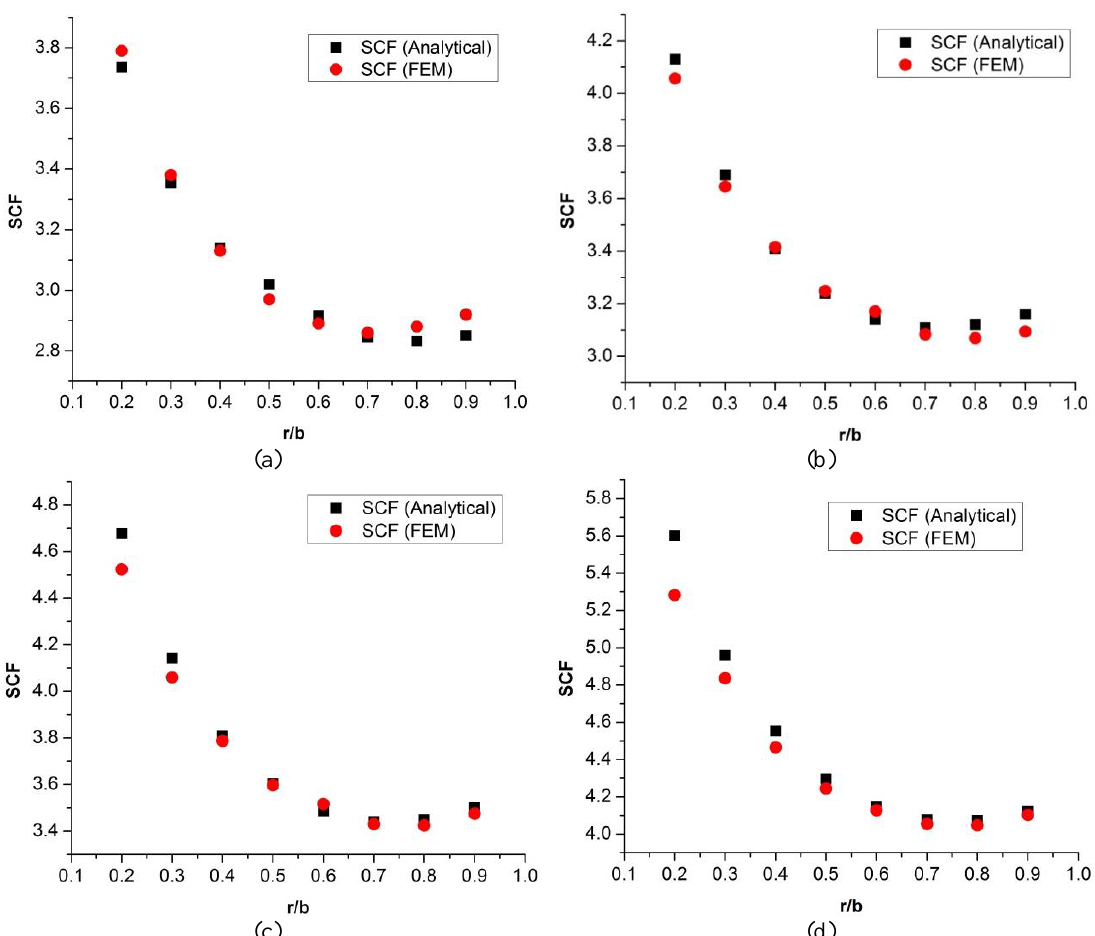
Figure 4. Variation of SCF with r/b for (a) b/a = 1, (b) b/a = 0.8, (c) b/a = 0.6 and (d) b/a = 0.4